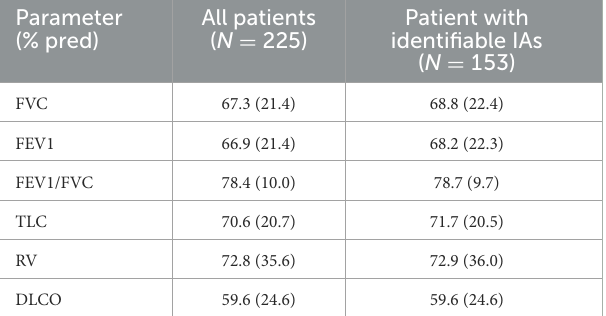
TABLE 2 Pulmonary function test in patients with or without identifiable inciting agents (IAs). Data = mean (standard deviation).